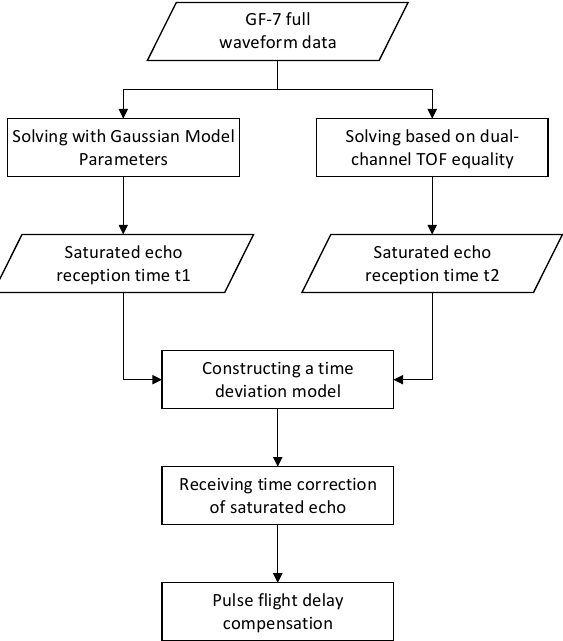
Figure 7. Flow diagram of the laser pulse delay compensation process.